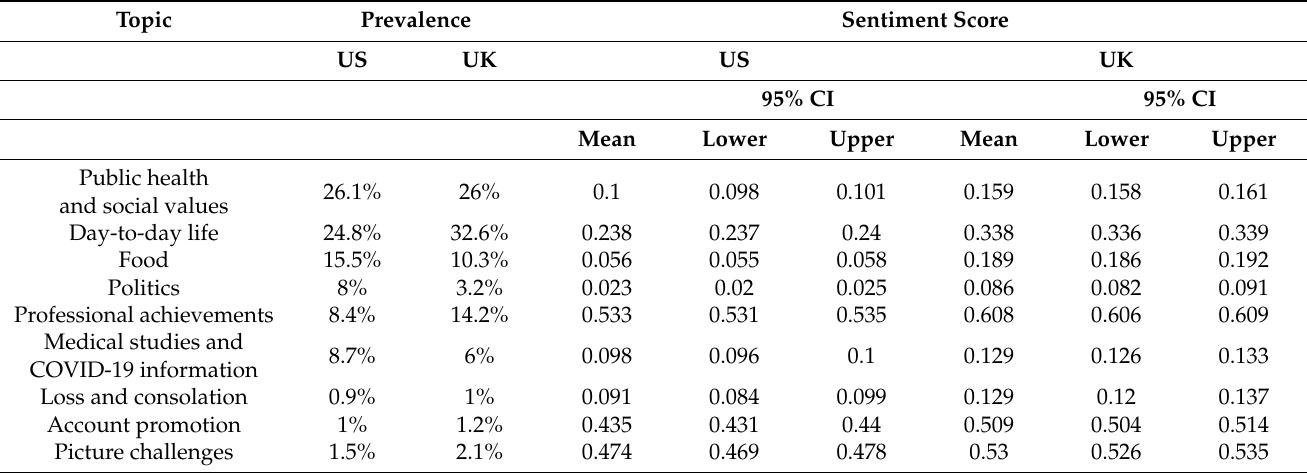
Table 2. Topic of discourse, prevalence, coherence, and average sentiment score in